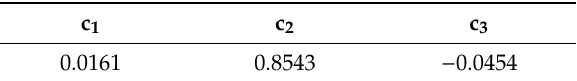
Table 3. Values of fitting parameters.